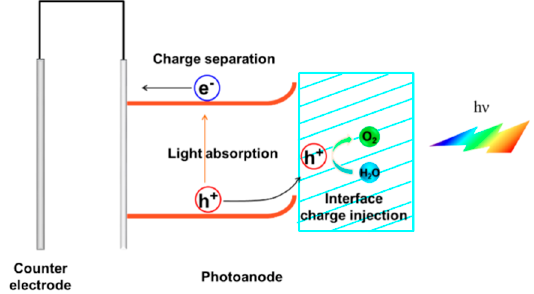
Figure 2. Schematic illustration of the three efficiencies of photoelectrochemical (PEC) water splitting for enhancing performance.